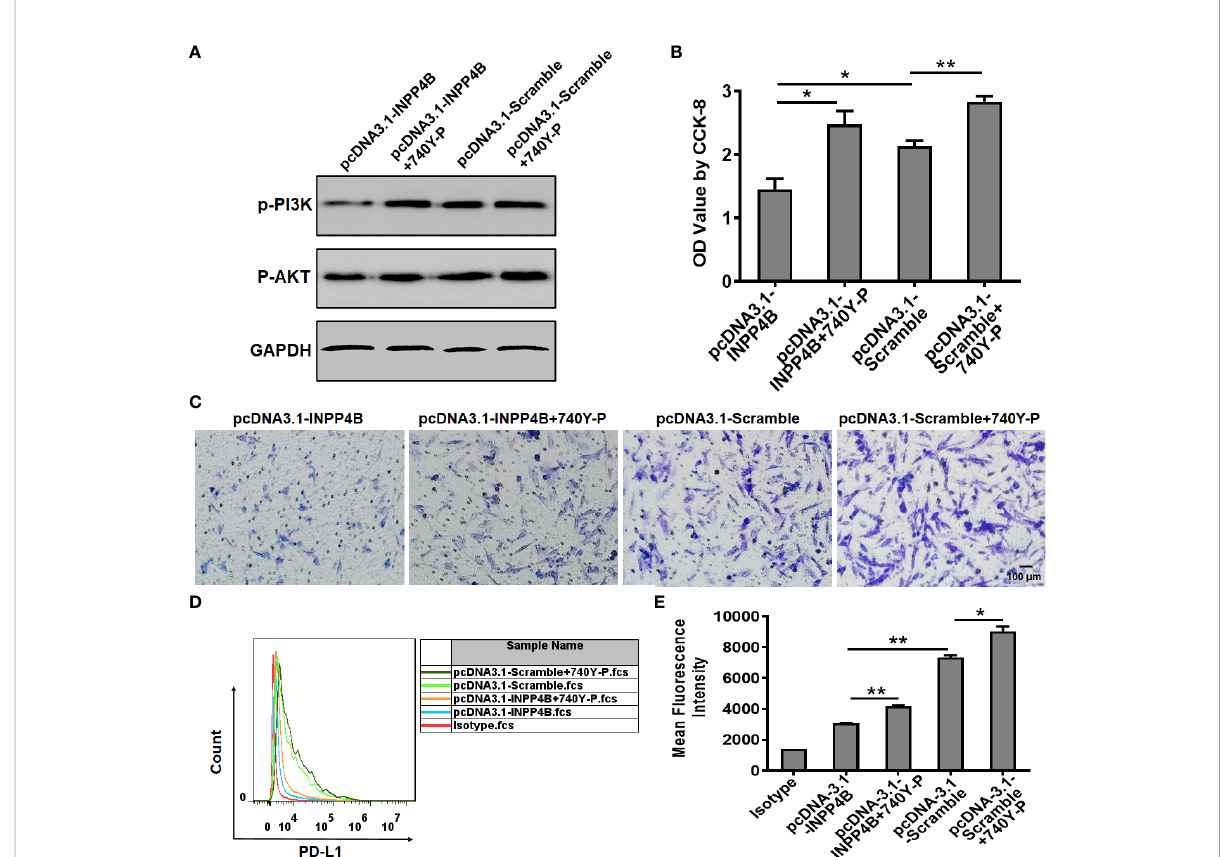
FIGURE 6 INPP4B overexpression restrains glioma cell proliferation, migration, and PD-L1 expression by down-regulating PI3K/AKT signaling. Effect of the PI3K/AKT activator 740Y-P on proliferation, migration, and PD-L1 expression in INPP4B-overexpressing U87 cells. (A) p-PI3K and p-AKT protein expression; (B) proliferation assessed by CCK-8 assay; (C) migratory properties assessed by transwell migration assay; and (D, E) PD-L1 expression assessed by fl ow cytometry. Values represent the means ± SD (n = 3); * p < 0.05, ** p <